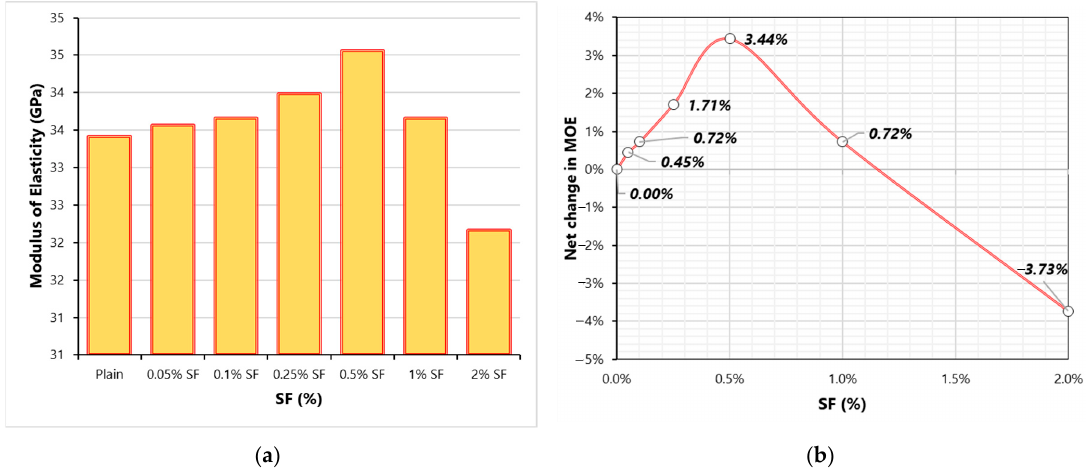
Figure 5. Modulus of elasticity (MOE) results ( a ) Variation of MOE with SF dosage ( b ) Net change in MOE with varying SF dosage.